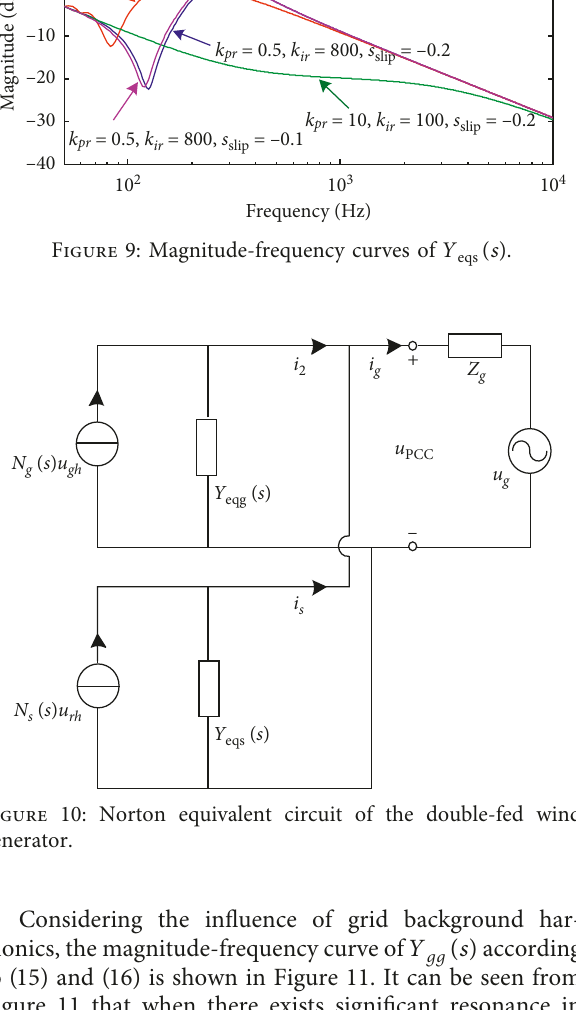
Figure 10: Norton equivalent circuit of the double-fed wind